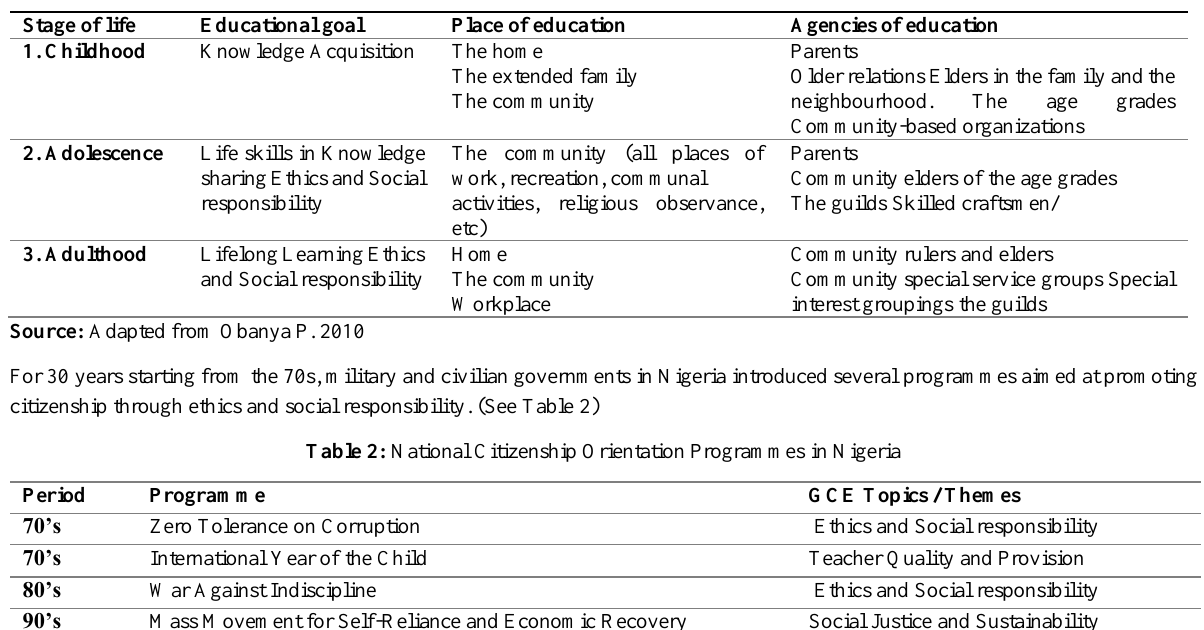
Table 1: Pre-colonial education in Nigeria